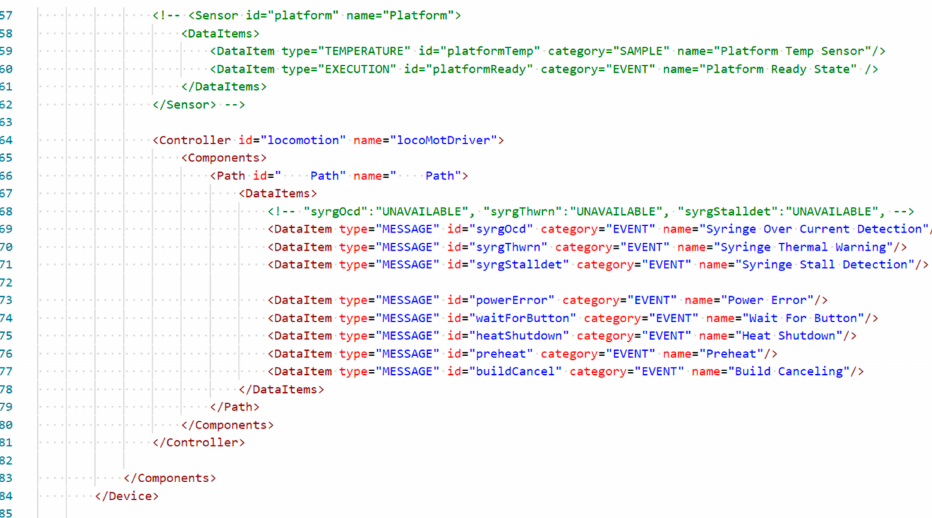
Figure 11. MTConnect agent monitoring major failure